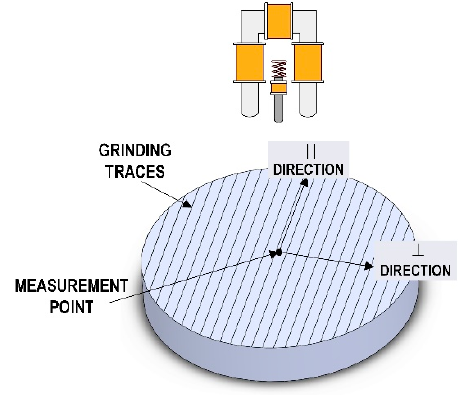
Figure 13. Details of the Barkhausen noise testing performed on specimens made of AMS 6414 steel. Table 3. Details of the measuring configuration.